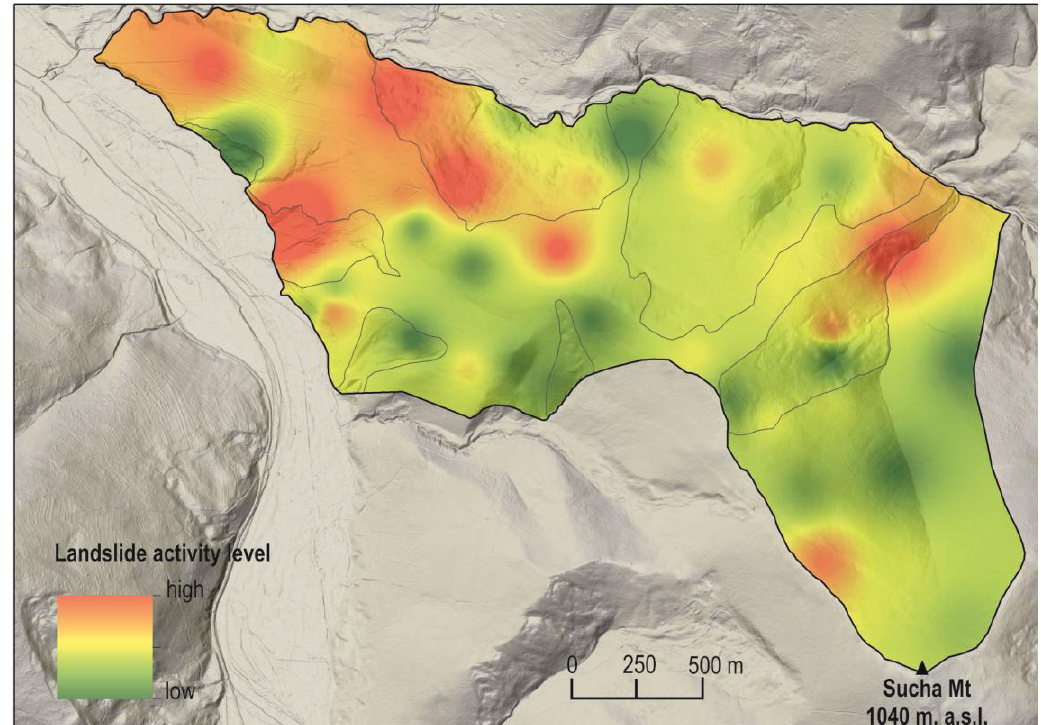
Fig. 5. Map of landslide activity on the Sucha Mountain massif determined on the basis of the results from the analysis of tree-ring eccentricity (shaded relief map based on DEM from LiDAR data; data